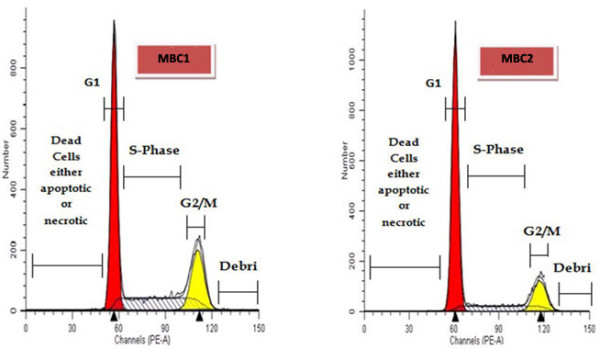
Cell Cycle Analysis of the MBC1 and MBC2 Cell Lines by Flow Cytometry Histogram. Enhancement in the S-phase fraction (SPF) demonstrates an unusual activity level of MBC1 proliferation compared to MBC2.